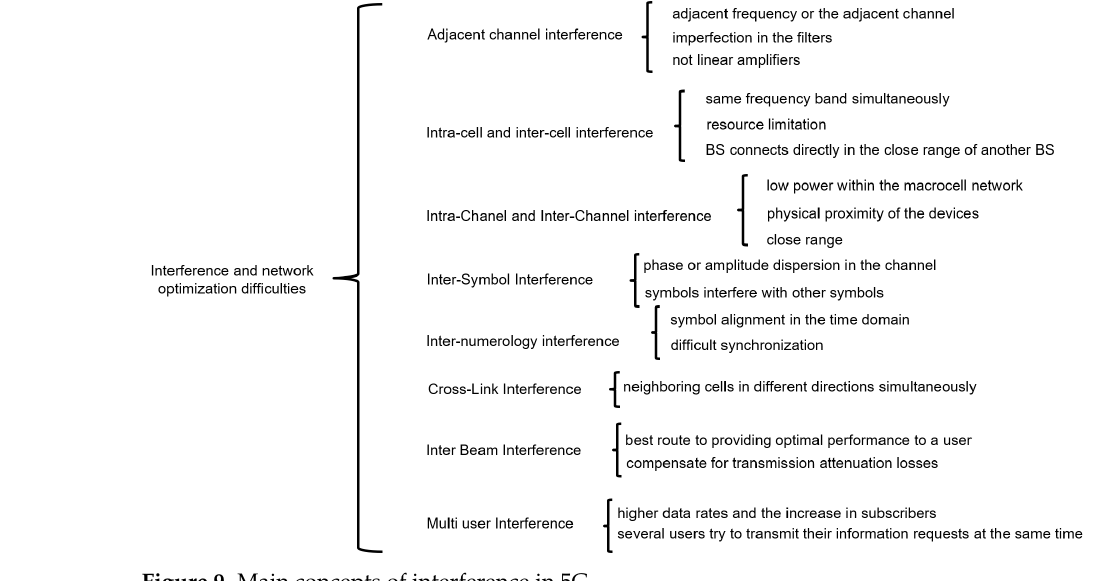
Figure 9. Main concepts of interference in